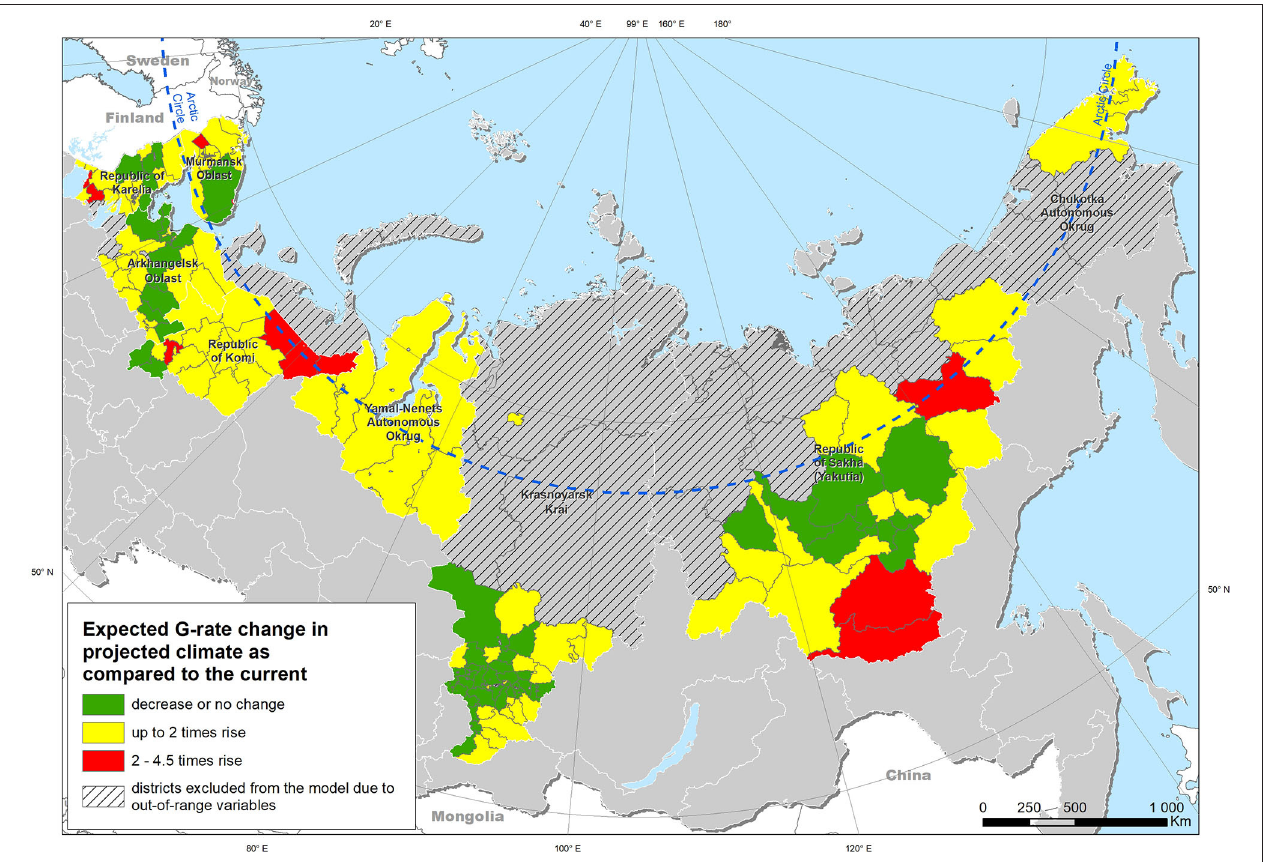
FIGURE 6 | Expected change in the density of leptospirosis cases under projected climate conditions in comparison with the current climate, based on modeled changes in climatic